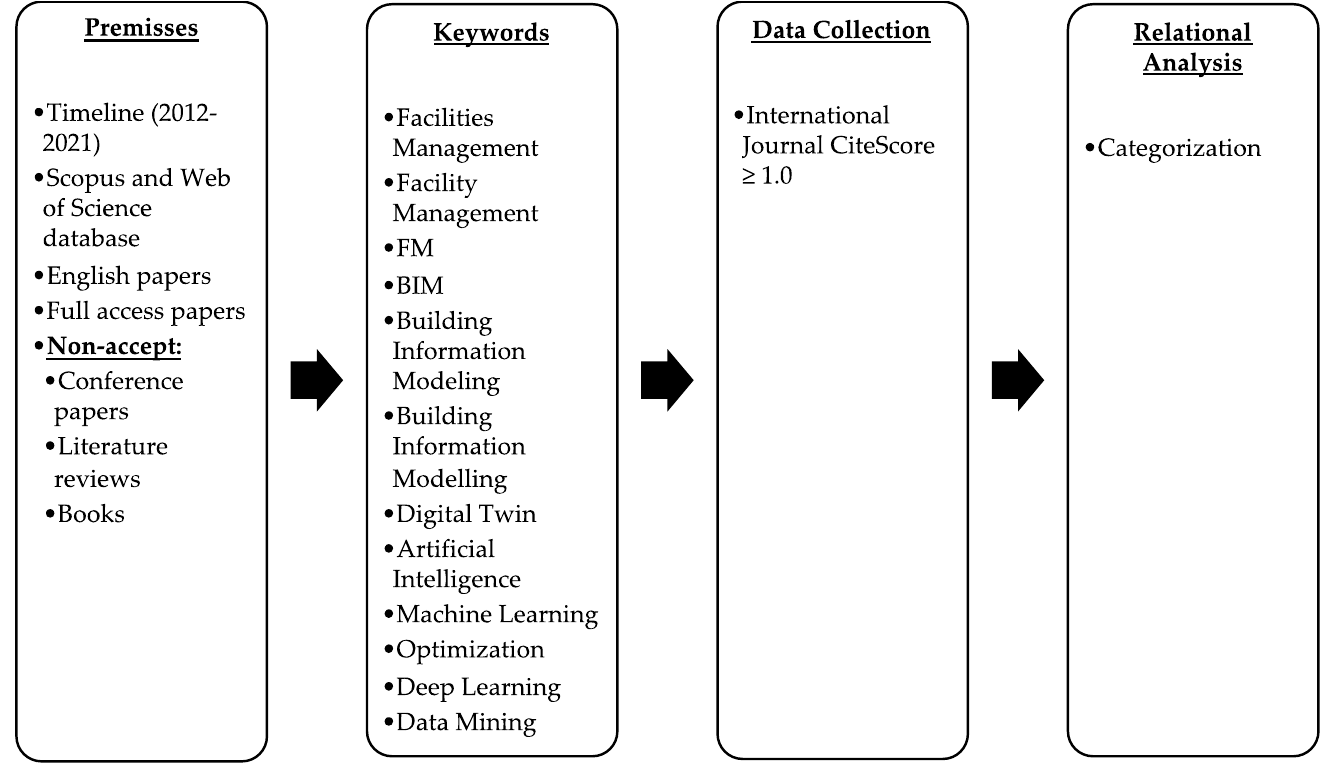
Figure 1. Research methodology.